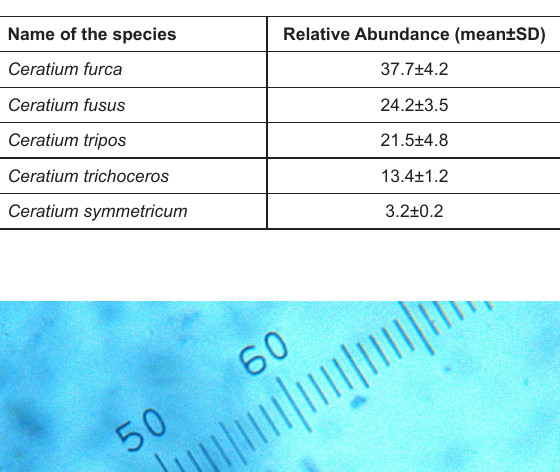
Table 2. Relative Abundance (mean ± standard deviation) of five species of the genus Ceratium